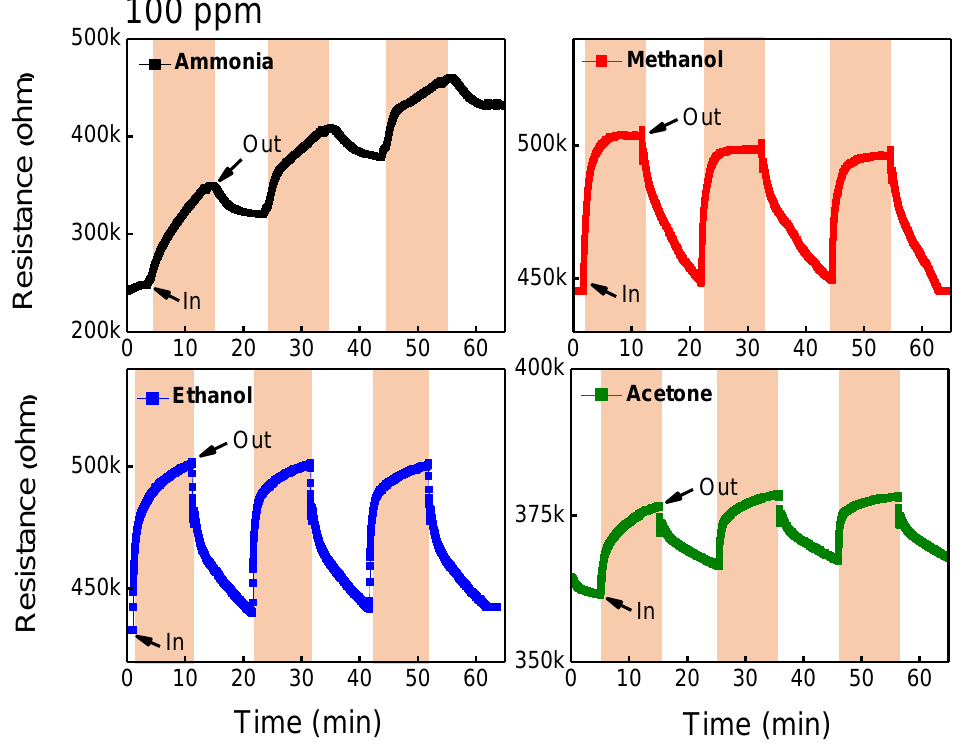
Figure 6. Gas-sensing results of UV irradiated GO/TiO 2 composite toward 100 ppm ammonia, methanol, ethanol, and acetone gas bubbling at room temperature (25 °C).